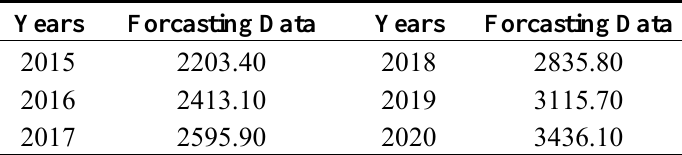
Table 11. Forecast of China’s biofuel production for 2015 to 2020 using the DGM (1,1) model.